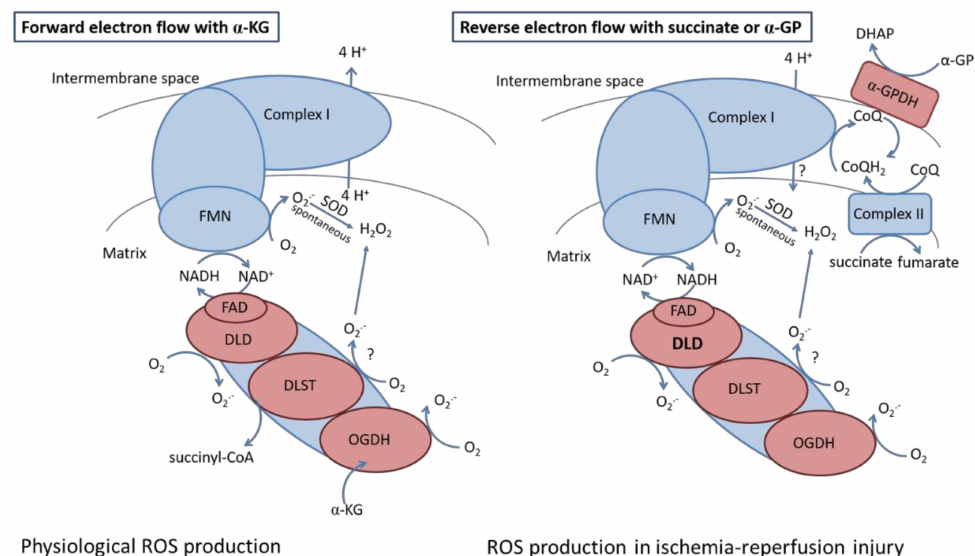
Figure 10. The role of KGDH in ROS production observed during forward and reverse electron transfer in ischemia-reperfusion injury. Abbreviations: α -GP: α -glycerophosphate; α -GPDH: α - glycerophosphate dehydrogenase; α -KG: α -ketoglutarate; CoQ: oxidized coenzyme Q; CoQH 2 : reduced coenzyme Q; DHAP: dihidroxiaceton-phosphate; DLD: dihidrolypoil dehydrogenase; DLST: dihydrolipoaminde succinyltransferase; FAD: flavin adenine dinucleotide; FMN: flavin adenine mononucleotide; OGDH: oxoglutarate dehydrogenase; SOD: superoxide